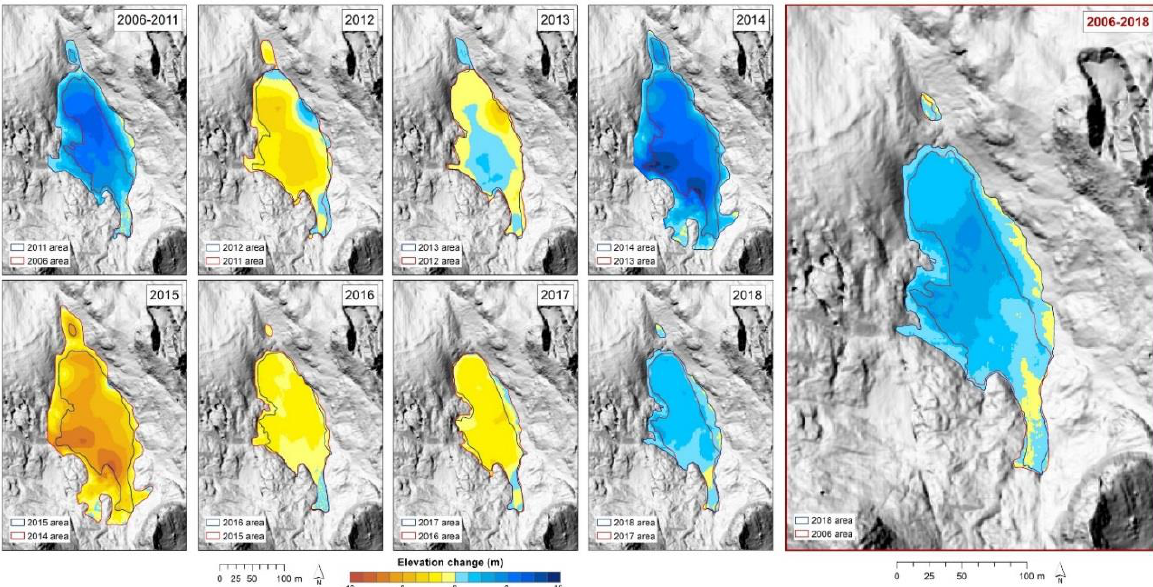
Figure 4. Surface elevation change of the Canin East GIP for the period 2006–2018 (see colored bar for elevation changes). Annual surface elevation change recorded between 2011 and 2018 refers to GCP survey, whereas a 5-year and a 12-year surface elevation change reported for the period 2006–2011 and 2006–2018, respectively, refers to Lidar derived surface elevation changes. The GIP outline was adjusted for every surveyed year, and the yearly area change was fully taken into account in the volume change calculations. The large topographic differences observed in some of the surveys, as in the case of the 2012–13, 2013–14 and 2014–15 hydrological years, are due to several different processes able to locally amplify the effect of extreme snow accumulation or ablation: (i) wind snow-blowing; (ii) irregular karst topography due to the presence of karstic shaft, hollows, dolines and canions; (iii) effect of avalanches; (iv) presence of